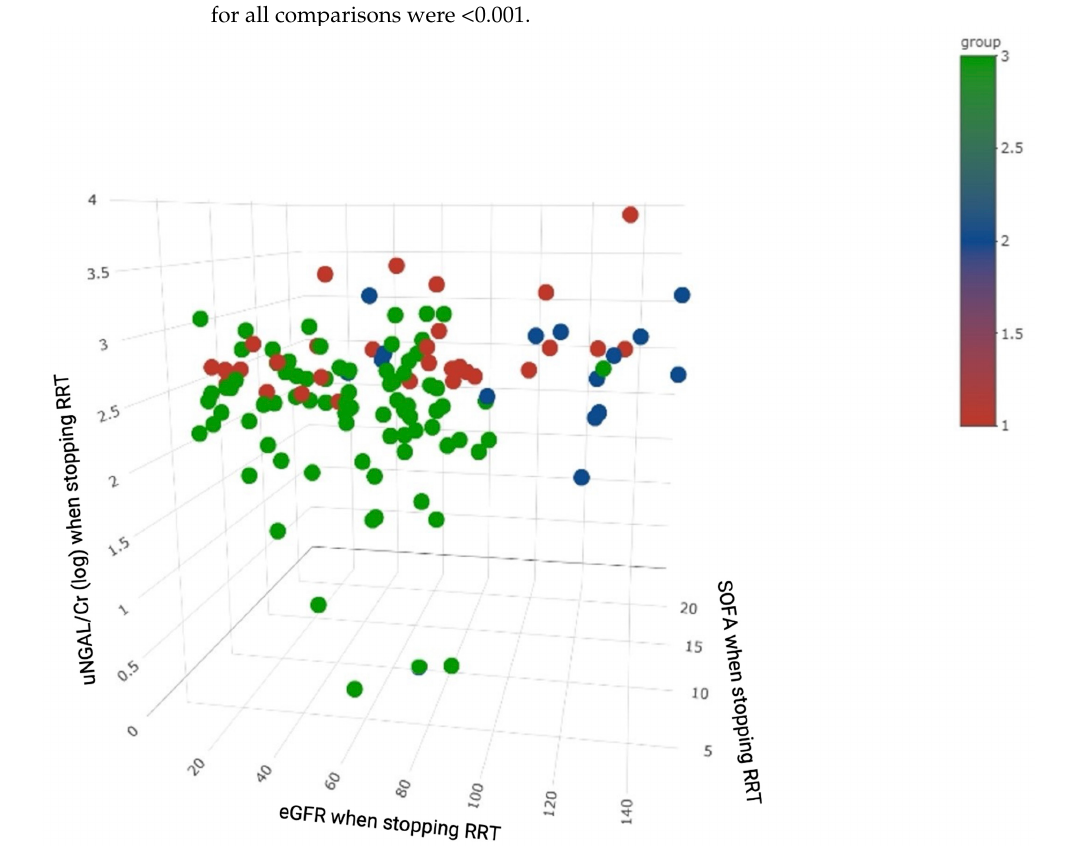
Figure 5. 3D scatter plot of patients with colors representing clustering by eGFR, SOFA score and uNGAL/Cr (log) at the time of weaning off RRT. Abbreviations: Cr, creatinine; eGFR, estimated glomerular filtration rate; RRT, renal replacement therapy; SOFA, Sequential Organ Failure Assess- ment; uNGAL, urinary neutrophil gelatinase-associated lipocalin. Table 2. Cox proportional hazards models depicting the 90-day mortality.